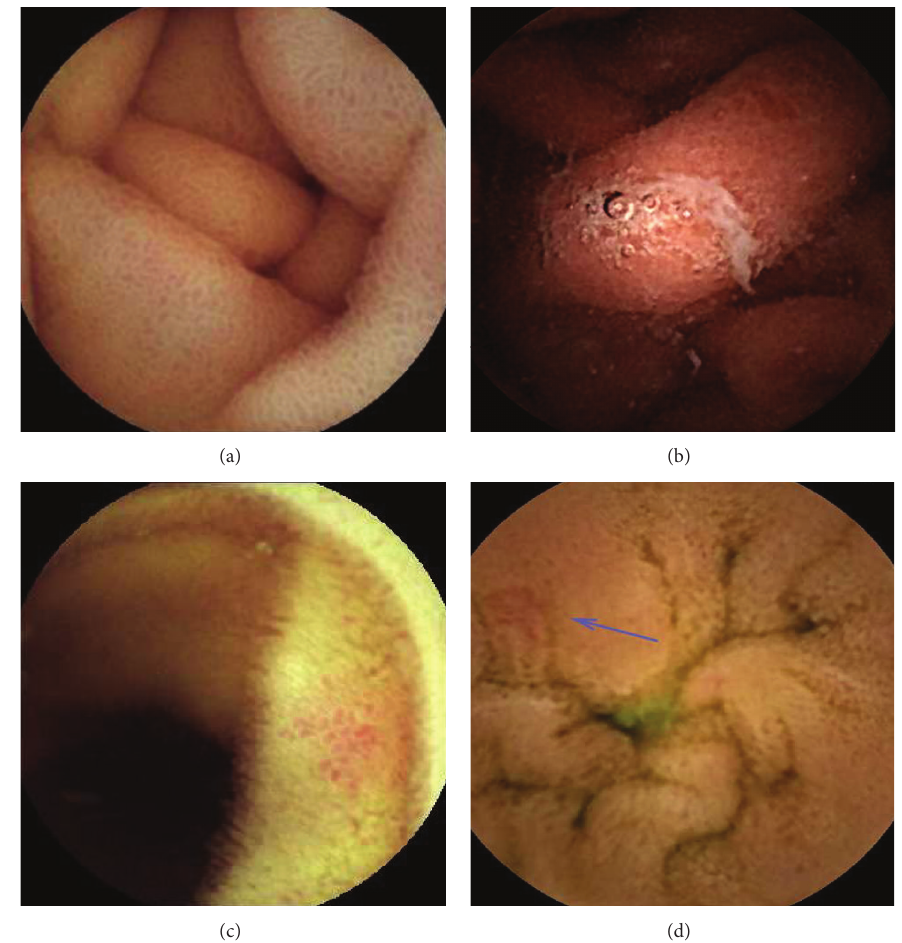
Figure 2: Portal hypertensive enteropathy (inflammatory-like abnormalities, grade 1) found by capsule endoscopy. (a) Reticulate pattern of the mucosa, (b) edematous mucosa with reticulate pattern, (c) hyperemic change with mucosal granularity, and (d) salmon roe appearance with hyperemia (blue